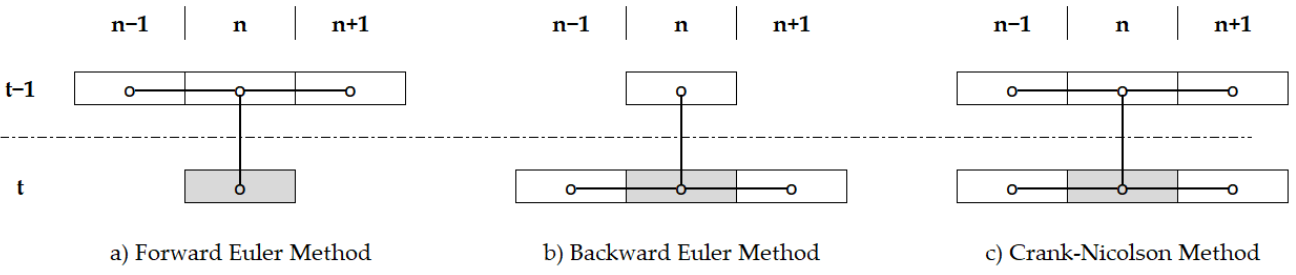
Figure 2. Schemes of the time discretization method—( a ) Forward Euler Method, ( b ) Backward Euler Method, ( c ) Crank- Nicolson Method [41].